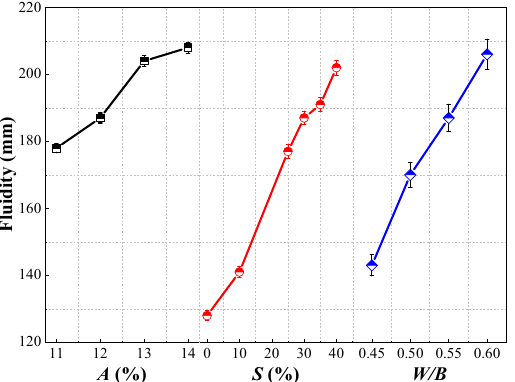
Figure 4. Fluidity of the CGBGM with different parameters.